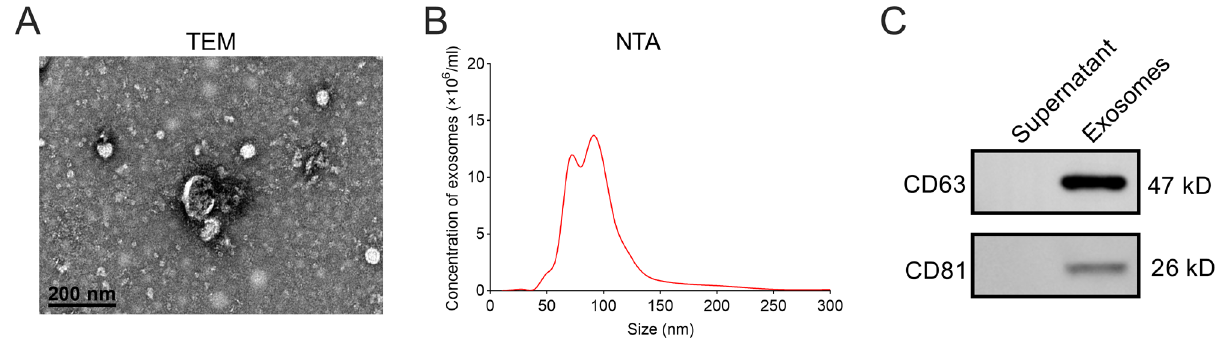
Figure 1 – Identification of Tregs-Exos. (A) Representative TEM images of Tregs-Exos isolated from conditioned medium. (B) Representative images of Tregs-Exos’ size distribution assessed by NTA. (C) Results of western blot analysis showed the presence of CD63 and CD81 in the